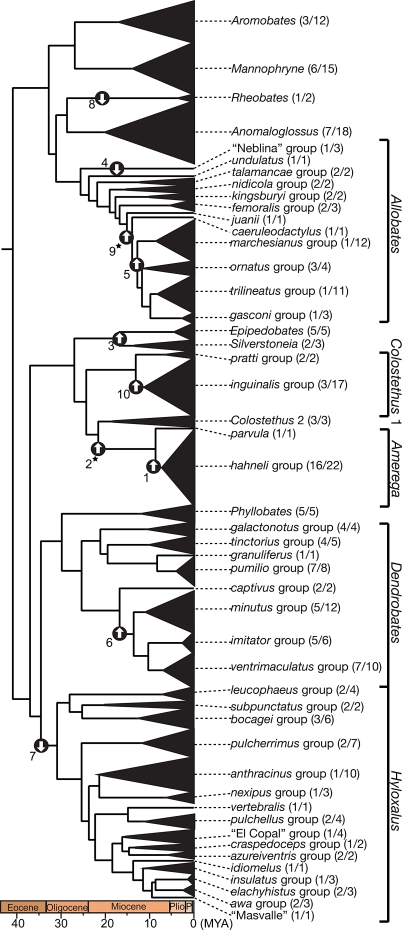
The Tree GSPF Level Tree Chronogram of Poison Frogs with Known Taxonomic Diversity (i.e., Numbers within Parentheses) and Significant Diversification Rate Changes for Nodes or Lineages from Table 3
Taxonomic diversity is indicated by the species sampled in our study (left number) and the total number of species described per group or genus (right number) (upward arrow indicates rate increase, and downward indicates rate decrease). The highest diversification increase (node 1) corresponds to the widespread Ameerega lineage that rapidly expanded into Amazonian since the late Miocene. The Andean-Amazonian increase (node 2) corresponds to the diversification of clade Colostethus 2 in the early Miocene. The Chocoan increases (nodes 3 and 10) correspond to the lowland radiation in western Colombian and Ecuadorian lowlands of Colostethus sensu lato, Epipedobates, and Silverstoneia during the middle Miocene and before the formation of the PLB. The Guiana decrease in the early Miocene (node 4) corresponds to the Allobates lineage of the Guianan tepuis. The Amazonian rate increases (nodes 5 and 9) correspond the largest radiation of Allobates since the Miocene to the Pliocene. The Andean-Amazonian increase (node 6) corresponds to the diversification of clade Dendrobates from the eastern Central Andean foothills into Amazonia since the early Miocene. The Andean decreases (nodes 7 and 8) correspond to a slow down of the diversification of Hyloxalus (clade B) and Rheobates (clade A) lineages during the late Oligocene and Pliocene, respectively. The significant increases indicated by a star next to nodes 2 and 9 might be dependent on deeper nodes (i.e., 1 and 5, respectively) and produced by a “trickle-down effect” (see “Lineage Diversification” in Results).